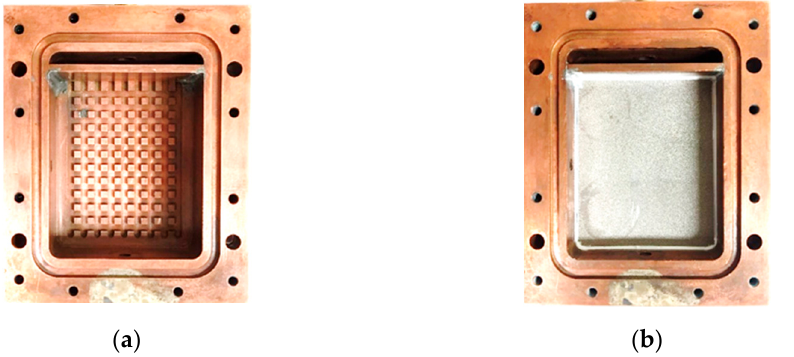
Figure 6. The inner surface geometry of the evaporator ( a ) before and ( b ) after installing the wick. Table 4. Uncertainty values.